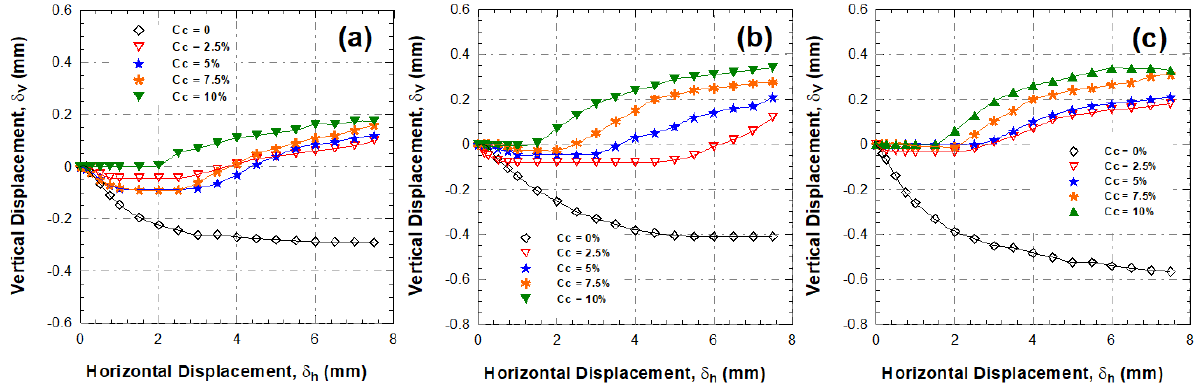
Figure 6: Cement content influence on the vertical displacement of cemented sand ( σn = 100 kPa), (a) ω = 3%, (b) ω = 7%, (c) ω = 10%.